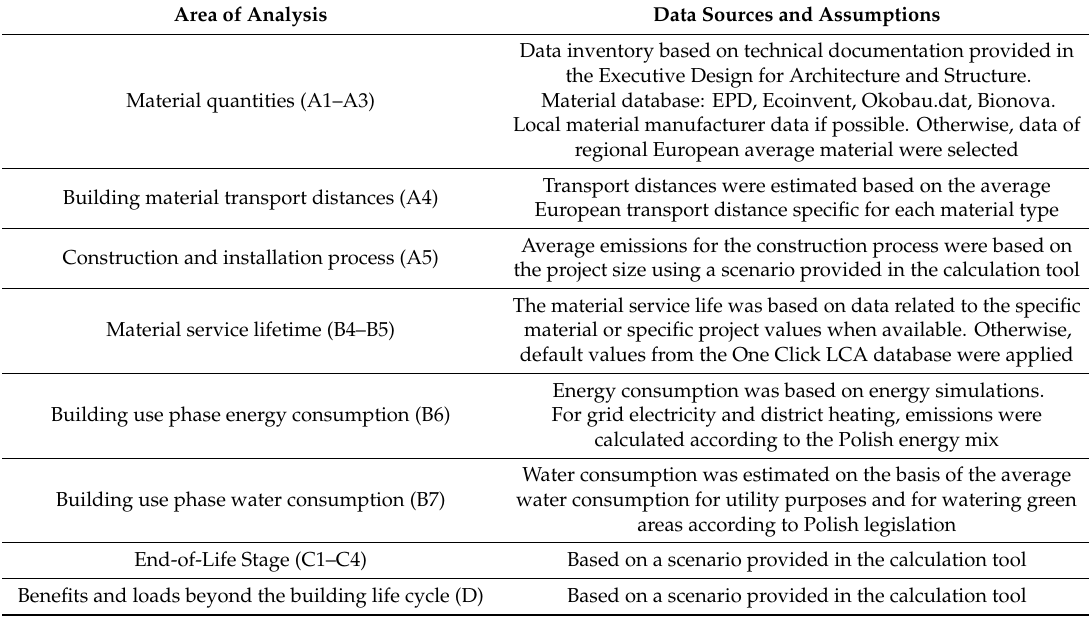
Table 3. Summary of Life Cycle Assessment (LCA) study assumptions.